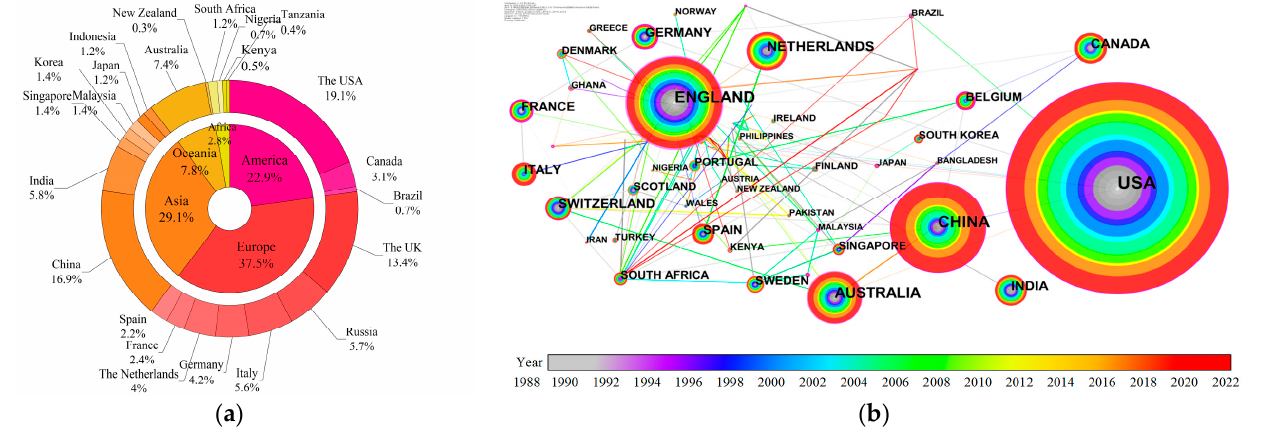
Figure 8. Geographic Heat And Academic Cooperation Analysis ( a ) Comparative Analysis of Global PPP Heat Maps; ( b ) National Cooperation Network Analysis Maps.